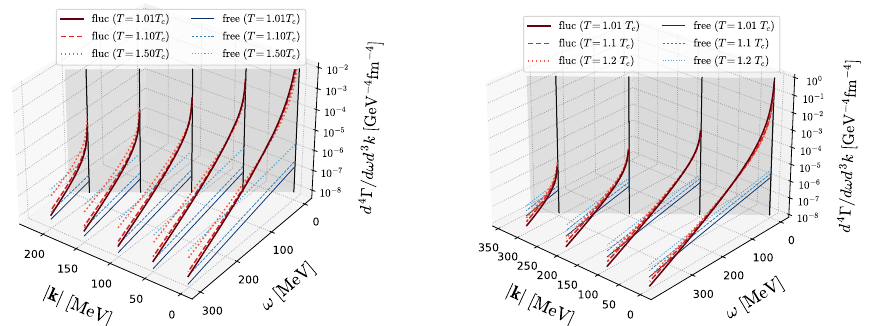
Figure 2: DPRs per unit energy ω and momentum k above T c of the 2SC at μ = 350 MeV (left) [2] and of the QCD CP at μ = μ CP (right) [3]. The thick lines are the contribution of the soft modes, and the thin lines are the results for the free quark